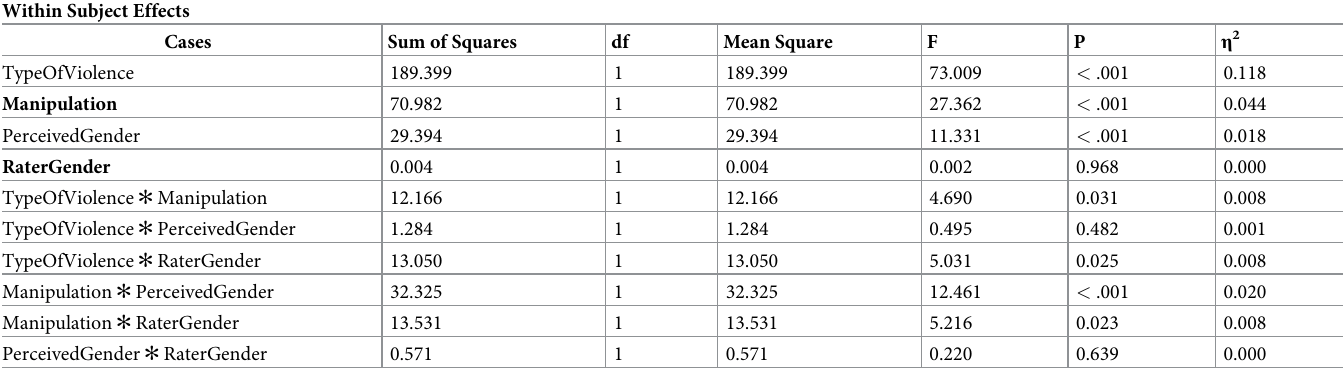
Table 4. ANOVA table for rating of seriousness by type of manipulation (original, gender reversed), perceived gender of the narrator, and rater